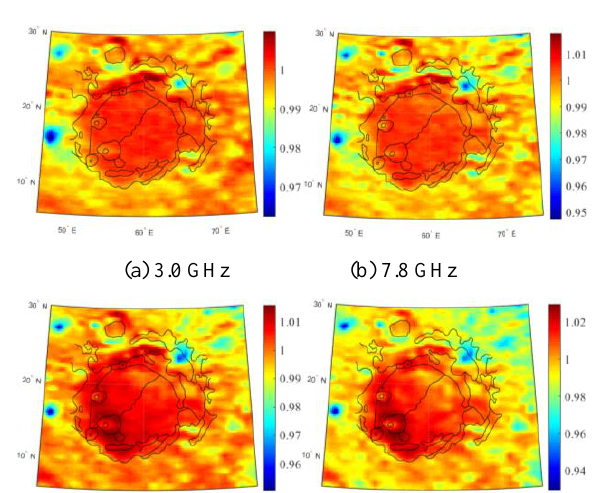
Figure 3. n T B at Noon of Mare Crisium